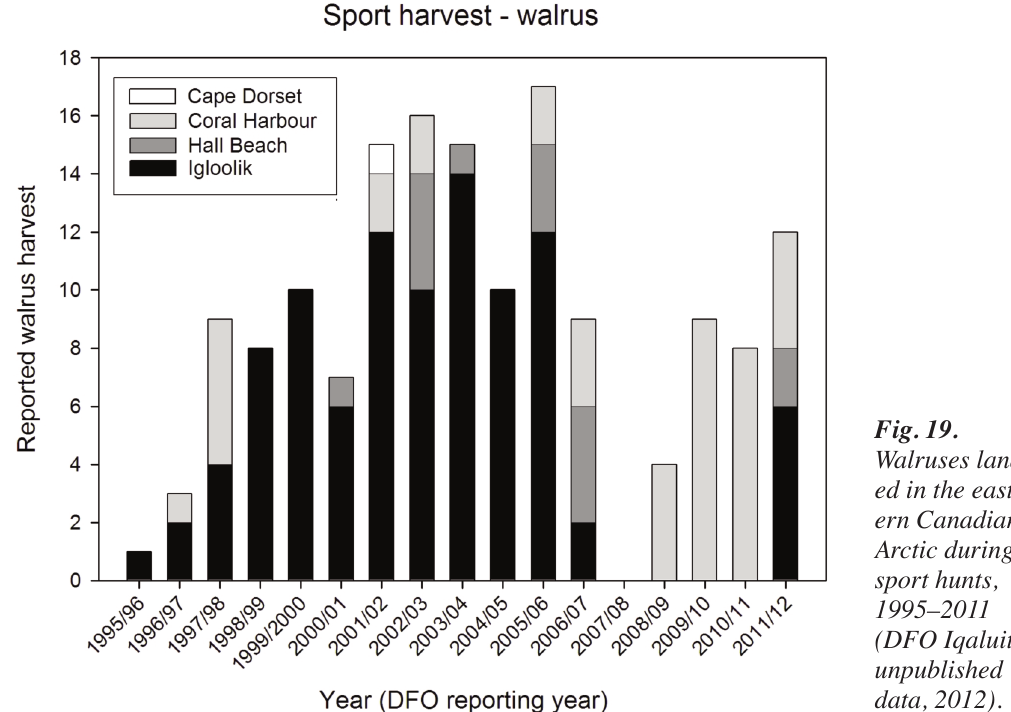
Fig. 19. Walruses land- ed in the east- ern Canadian Arctic during sport hunts, (DFO Iqaluit, unpublished data,